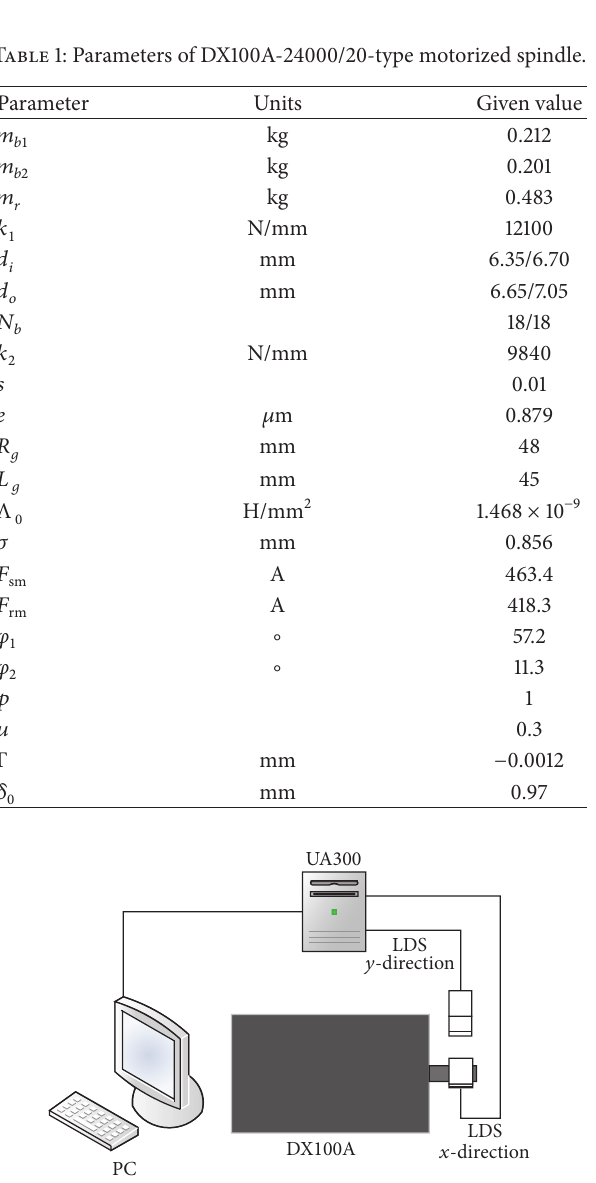
Figure 4: Experimental setup.